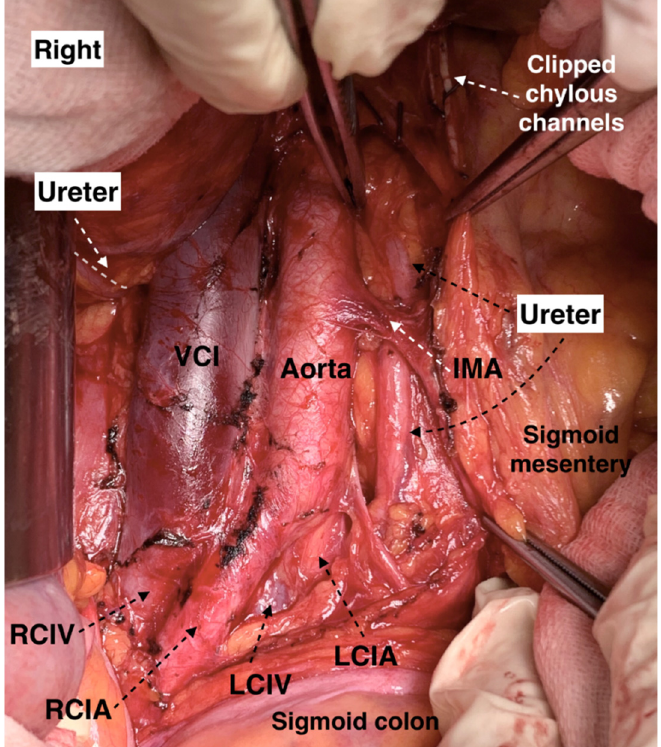
Figure 12. Left ureter at the lateral aspect of the abdominal aorta, which is identified under the mesentery of the sigmoid colon (open surgery performed by doctor Ilker Selcuk). IMA—inferior mesenteric artery, LCIA—left common iliac artery, LCIV—left common iliac vein, RCIV—right common iliac vein, RCIA—right common iliac vein, VCI—vena cava inferior.